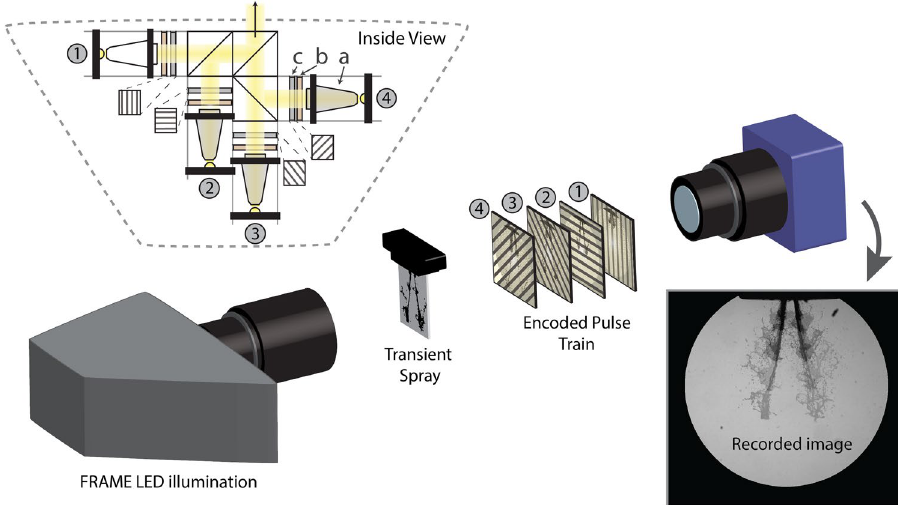
Figure 2. Recording an injection event with FRAME. The light from four pulsed white-light LEDs are led through individual optical arms consisting of a tapered light pipe with 3 × magnification ( a ), a diffusor ( b ) and a Ronchi grating ( c ). Beamsplitters recombine these into a collinear pulse train. After passing through an objective lens, they illuminate the sample with a spatially modulated pulse train (indicated with numbers). The pulse train is subsequently recorded on a camera of choice within a single